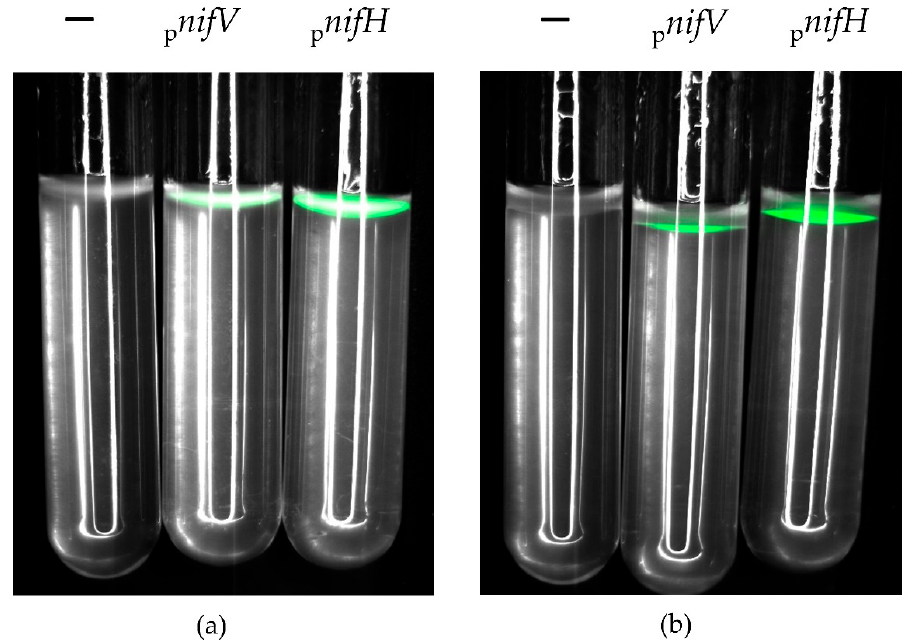
Figure 5. GFP expression of P. phymatum STM815 nifV and nifH reporter strains grown in free-living condition under 15 mM ( a ) and 0.3 mM NH 4 ( b ) for 21 days at 28 °C. (A)BS soft agarose tubes were